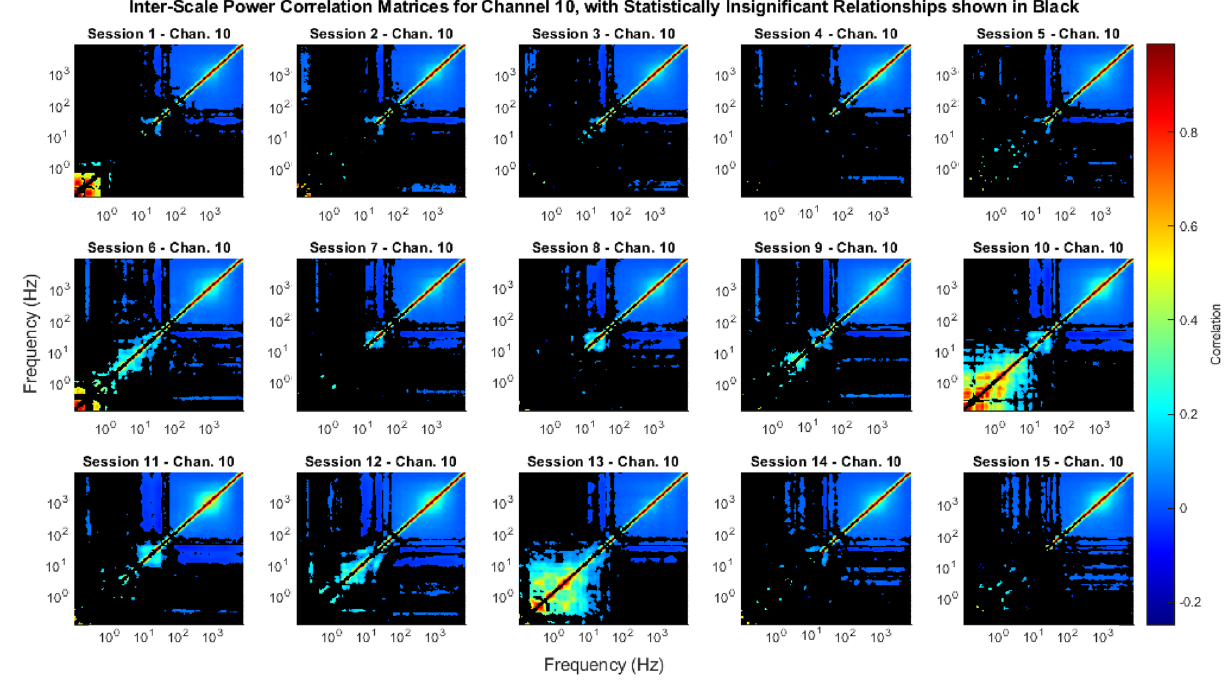
Figure 3. ISPCMs from Sessions 1–15 for Channel 10. These show the time-wise correlation between the power in various frequency bands, i.e. ISPCs. Non-statistically significant correlations, at an FDR α of 0.01, are shown in black.